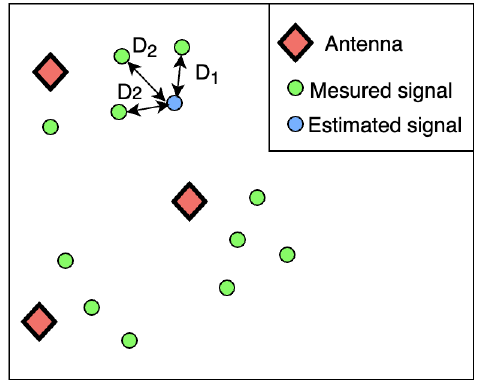
Figure 4. Signal estimation with KNN algorithm (K =